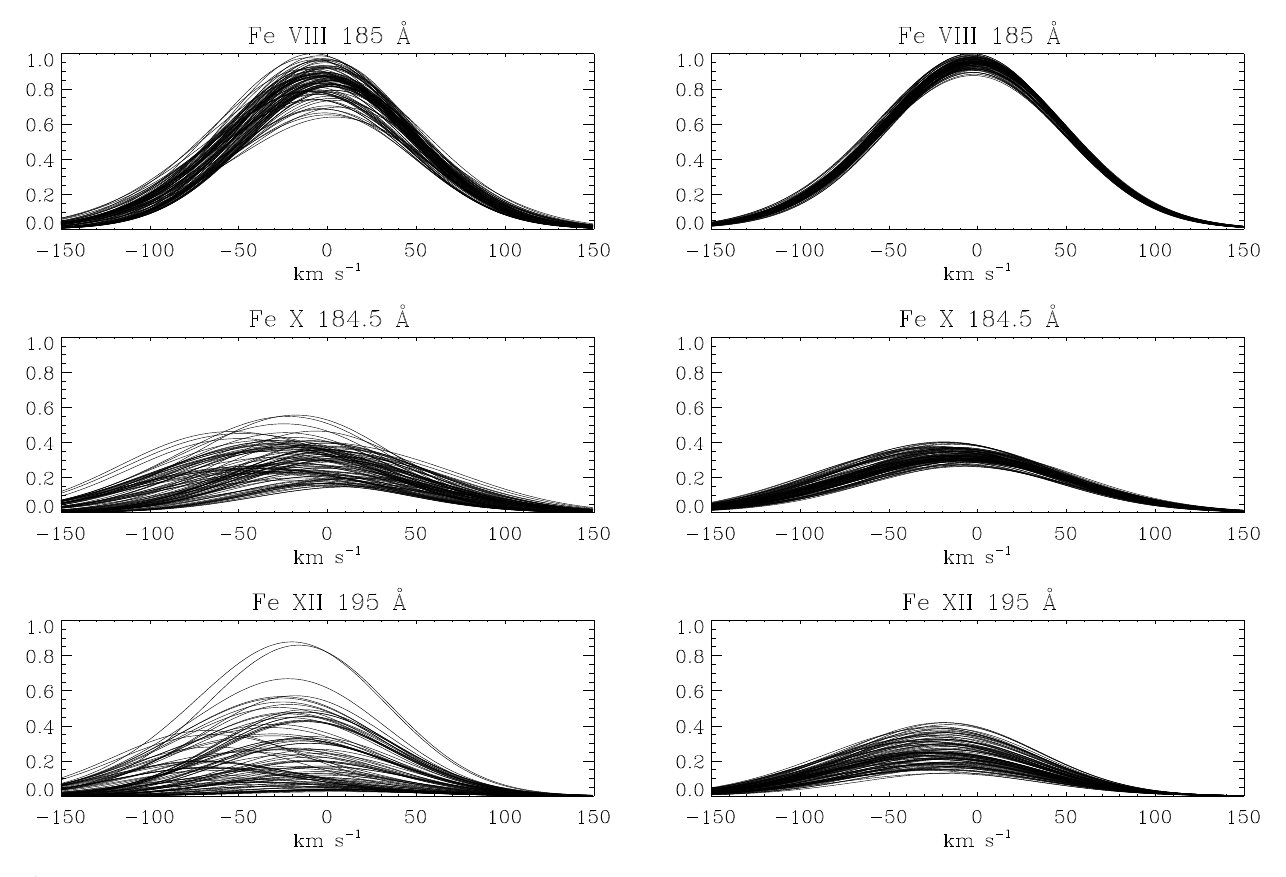
Figure 6. Synthetic line profiles, from a 5000s simulation, for a loop consisting of 100 strands. There is a 50s interval between each plotted